Question: Write a caption explaining this figure to a reader.
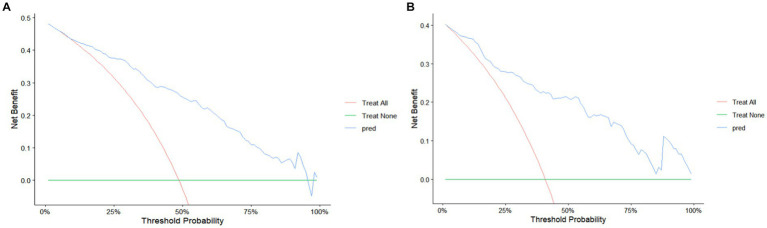
Answer: (A) Decision curve analysis of the training set. (B) Decision curve analysis of the validation set.